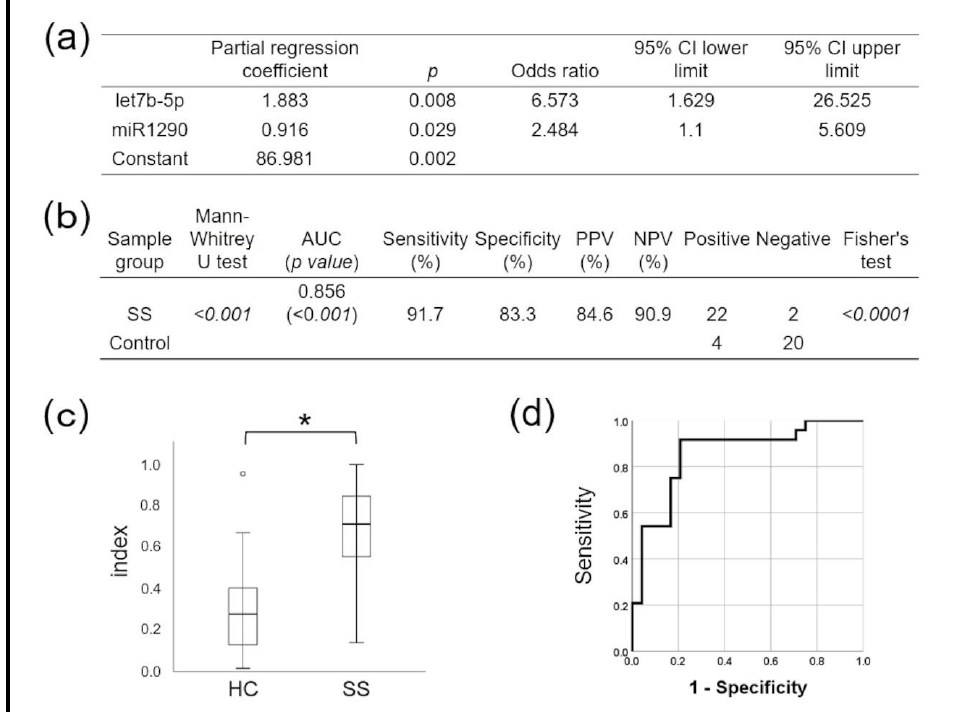
Figure 4. Diagnostic performance of two combined microRNAs (miRNAs) for Sjögren syndrome (SS), determined using a diagnostic (miRNA) index and calculated using logistic regression analysis. ( a ) Results of logistic regression analysis. Model ’ s X² test p < 0.001, Hosmer – Lemeshow test p = 0.836, disease discrimination rate = 81.2%. Prediction formula = 1/(1 + exp ( − 1 × score)). Score = 86.981 + (1.883 × let7b-5p) + (0.916 × miR1290). ( b ) Ability of miRNA index to diagnose Sjögren syndrome (SS) based on cut-off value of ROC curve. ( c ) There was a significantly higher miRNA index in SS patients than in controls (* p < 0.001, Mann–Whitney U tests). ( d ) Diagnostic performance based on AUC, 0.856; sensitivity, 91.7%; specificity, 83.3%. AUC, area under the ROC curve; NPV, negative predictive value; PPV, positive predictive value; ROC, receiver operating